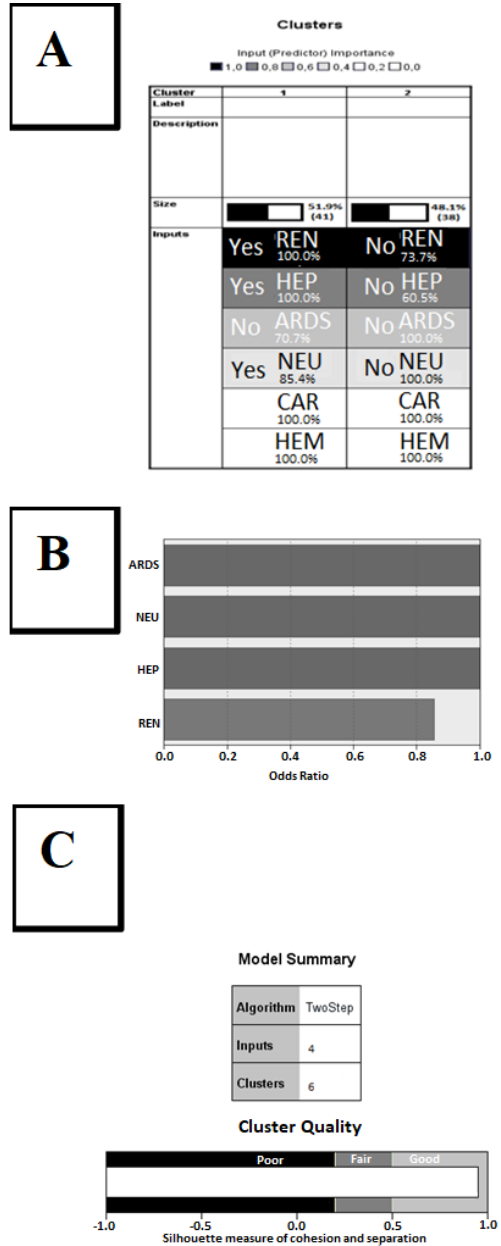
Figure 5. Cluster analysis of organ dysfunctions. ( A ) Graphic output of two-step cluster analysis based on 6 organ dysfunctions ( n = 101) used to define the SOFA score. Organ dysfunctions mentioned: REN = renal, HEP = hepatic, ARDS = respiratory distress, NEU = neurologic, CAR = cardiac, HEM = hematologic. Intensity of grey indicates the discriminating power of input variables. White background indicates no discriminating power of the listed variables. CAR and HEM have no influence on the classification. Two clusters, marked 1 and 2 in the first line of the table (Cluster Label), were found in this preliminary run. ( B ) Graphic output of the second run of two-step cluster analysis based on only 4 of the 6 organ dysfunctions ( n = 101; CAR and HEM were kept out), displaying the discriminating power of each organ dysfunction as odds ratio. For abbreviations, see ( A , C ). ( C ) Graphic output of the second run of two-step cluster analysis based on only 4 organ dysfunctions ( n = 101, CAR and HEM not in use), displaying cluster quality as good, based on cohesion of cases within clusters and separation of clusters. Six well-defined clusters, plus one cluster with cases that could not be classified (“miscellaneous” or “ − 1”), were identified. For abbreviations, see ( A ).